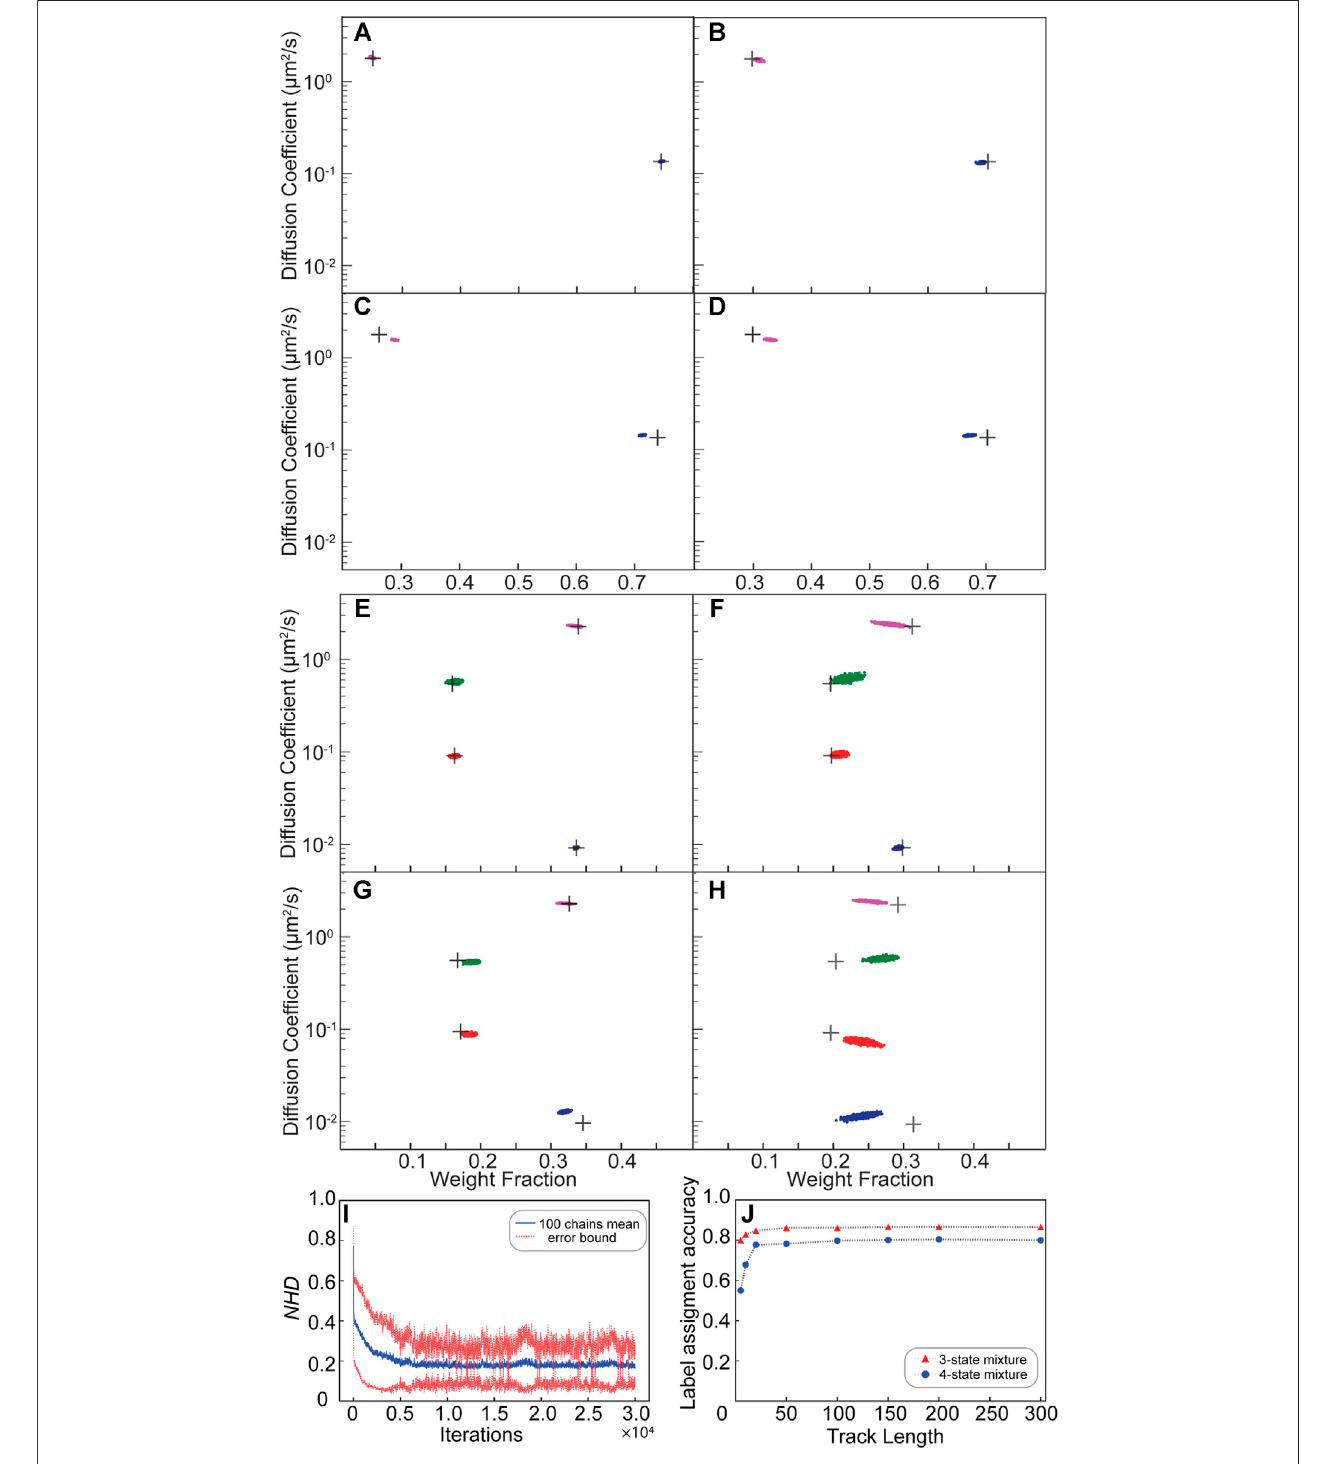
FIGURE 2 | Validation of the NOBIAS HDP-HMM module with simulated trajectories. (A – H) The HDP-HMM module identi fi es distinct mobility states (colored clusters). All scatter plots include at least 500uncorrelated samples. Each point representsthe average apparent single-molecule diffusion coef fi cient vs. weight fraction in each distinct mobility state at each iteration of the Bayesian algorithm saved after convergence. The black crosses indicate the ground truth input for these simulated trajectories. (A – D) Results for two-state mixture simulated trajectories results: (A) Standard (no motion blur) and abundant (500 100-step trajectories) simulations, (B) Standard and sparse (2,000 10-step trajectories) simulations, (C) Motion blur and abundant simulations, and (D) Motion blur and sparse simulations. (E , H) Results